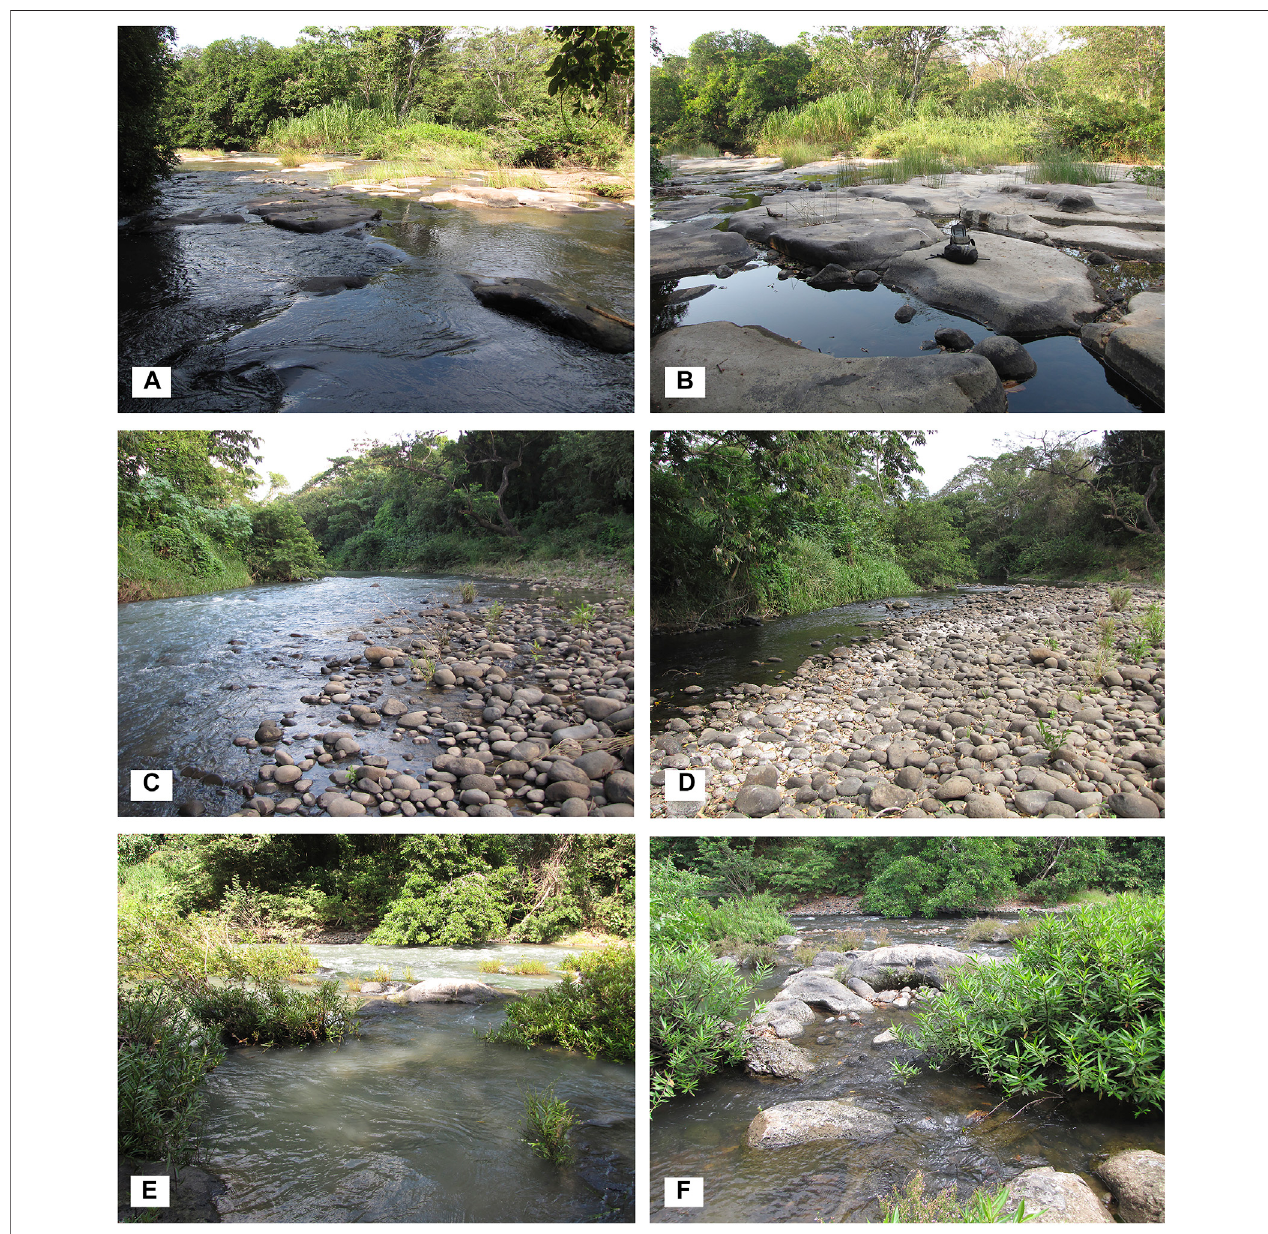
FIGURE2| Coloradoriver (A) Site-1November 2009; (B) Site-1February2010; (C) Site-2November 2009; (D) Site-2February2010; (E) Site-3November2009; (F) Site-3 February 2010. [ (A – F) : from left to right and from above to below].